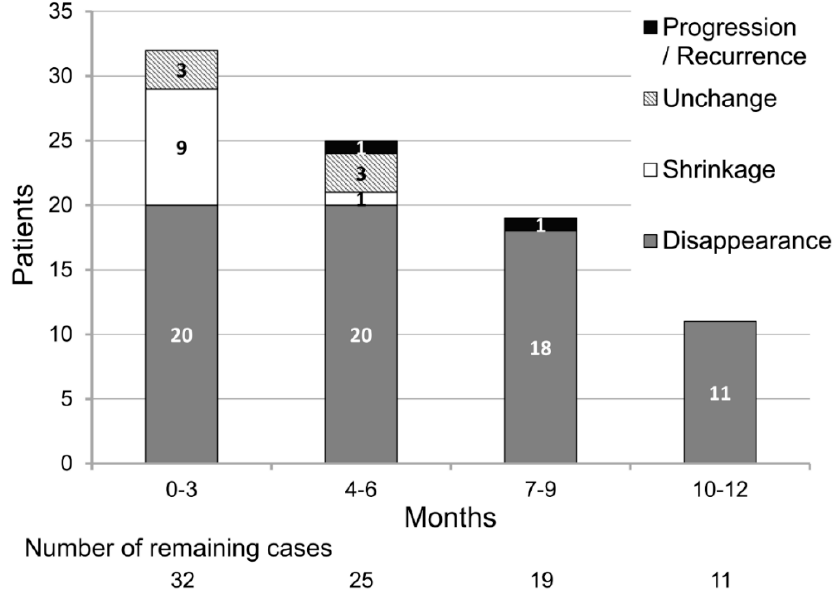
Figure 2. Results of repeat venous thromboembolism (VTE) evaluation during the overall analysis period. Therefore, the null hypothesis for the primary endpoint (thrombus disappearance rate of ≤ 32.0%) was rejected (one-tailed, p < 0.025 regarded as significant, p = 0.00038). In the analysis of